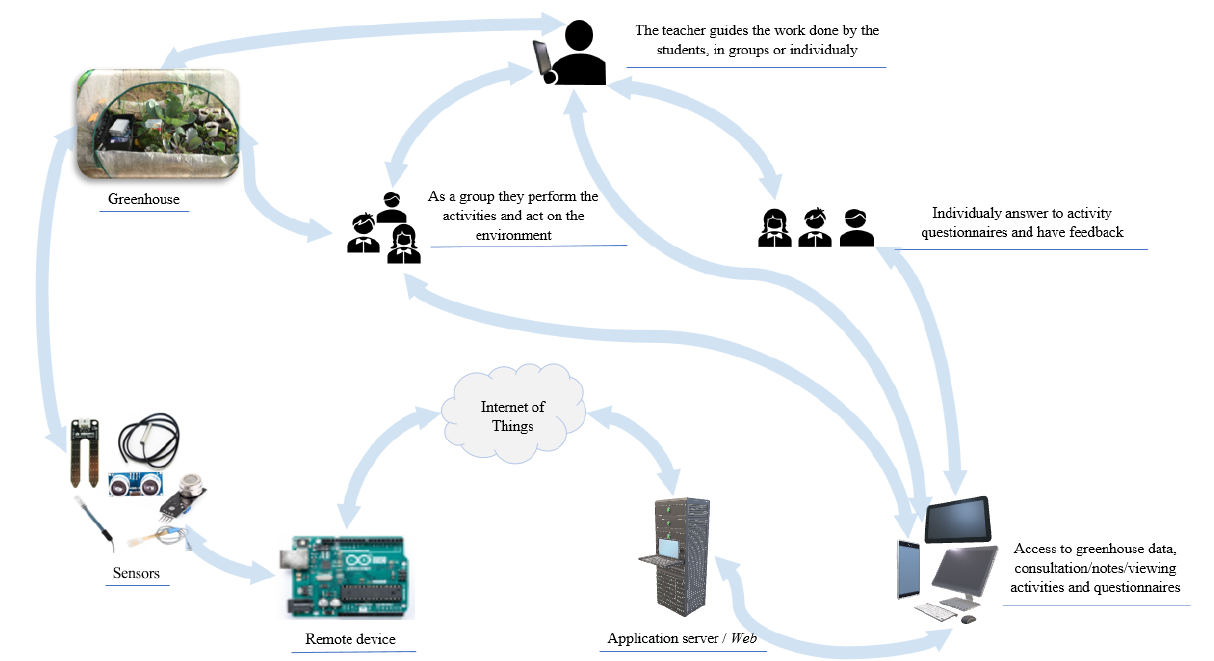
Figure 1. Interaction between the different targets of the SOLL project, prepared by the authors In this interdisciplinary way, students achieve what is required in the Student Profile when Exit Compulsory Schooling, in which “Areas of Competence add competences understood as complex combinations of knowledge, skills and attitudes that allow effective human action in diverse contexts. They are of diverse nature: cognitive and metacognitive, social and emotional, physical and practical. It is important to emphasize that competences involve knowledge (factual, concetual, procedural and metacognitive), cognitive and psychomotor skills, attitudes associated with social and organizational skills, and ethical values (Martins et al., 2017: